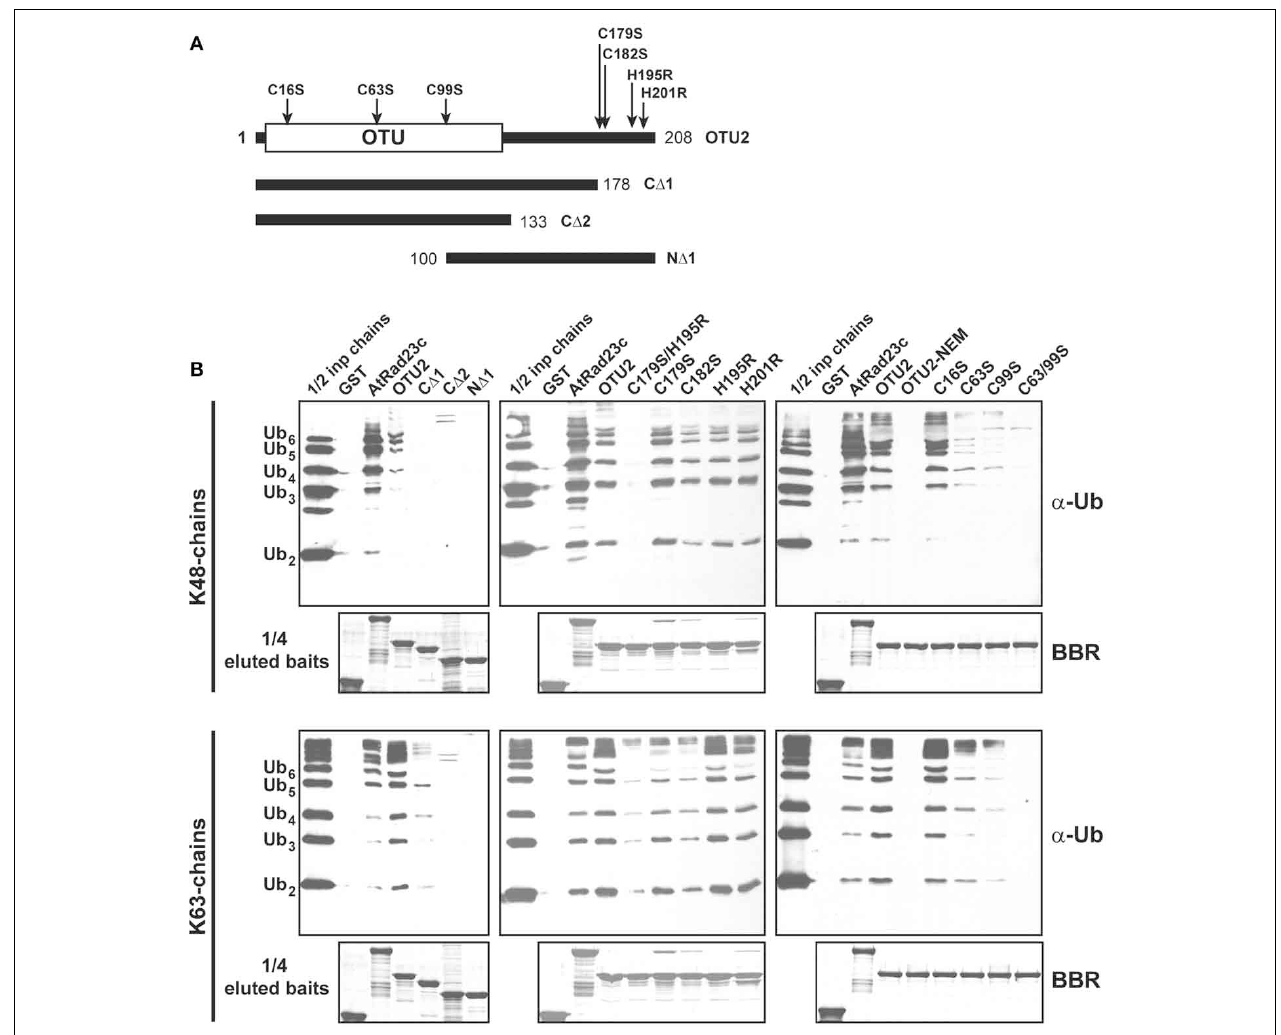
FIGURE 8 | Residues located at both the OTU2 N- and C-termini are critical for ubiquitin chain binding. (A) Schematic diagrams of the site-specific and deletion variants of OTU2 that were used to delineate the domains and residues involved in UB binding. The site-specific mutations and OTU domain are indicated. The numbers indicate the coordinates for the OTU2 variant termini. (B) GST pull-down products. Five micrograms of K48- or K63-linked UB chains (2–6 units, labeled on the left) were subjected to pull down by GST-fused OTU2 variants and